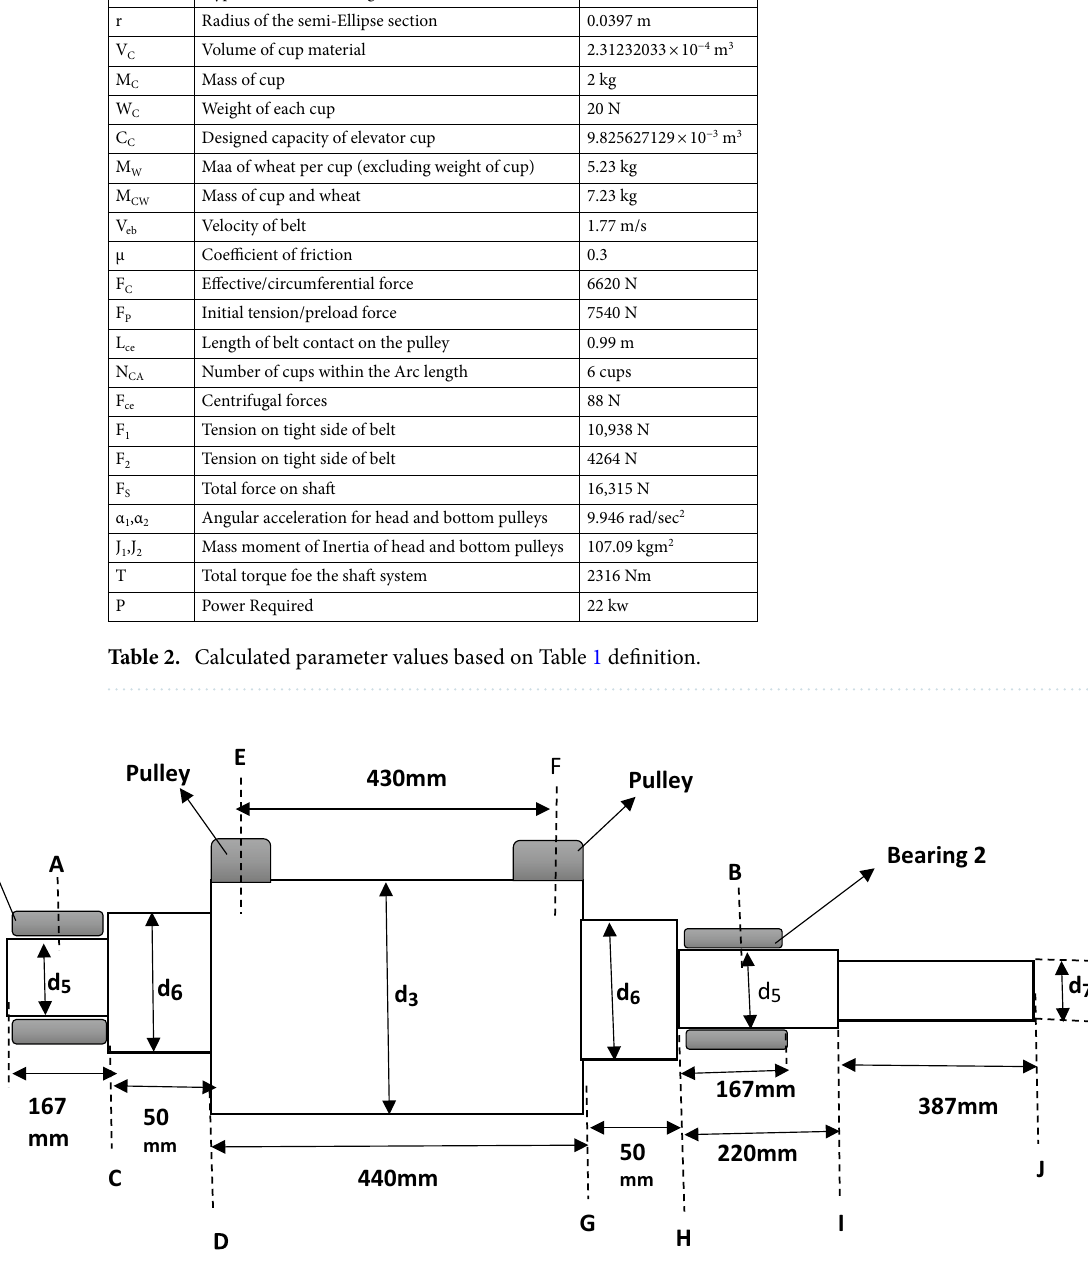
Figure 11. Schematic diagram of the